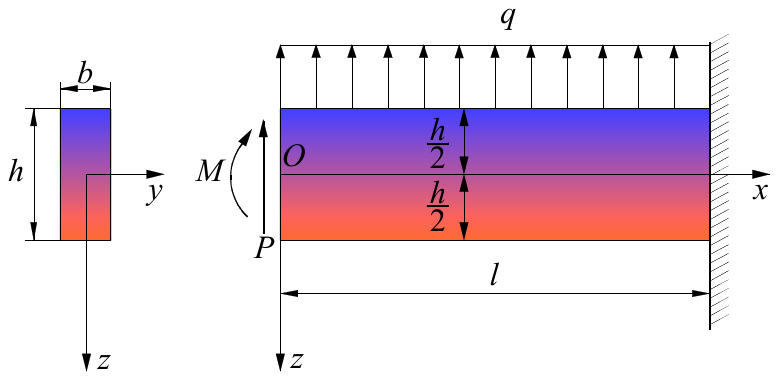
Figure 1. Scheme of a functionally graded piezoelectric cantilever beam.